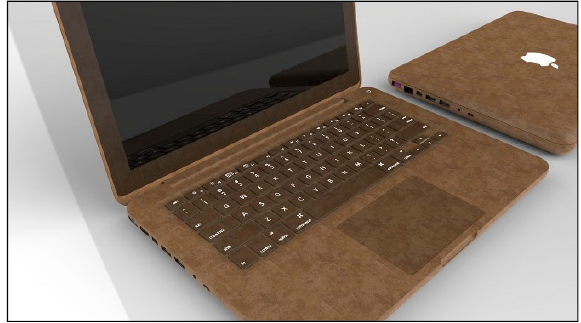
Figure 13. Laptop casing made from hemp/PLA based composites [114].